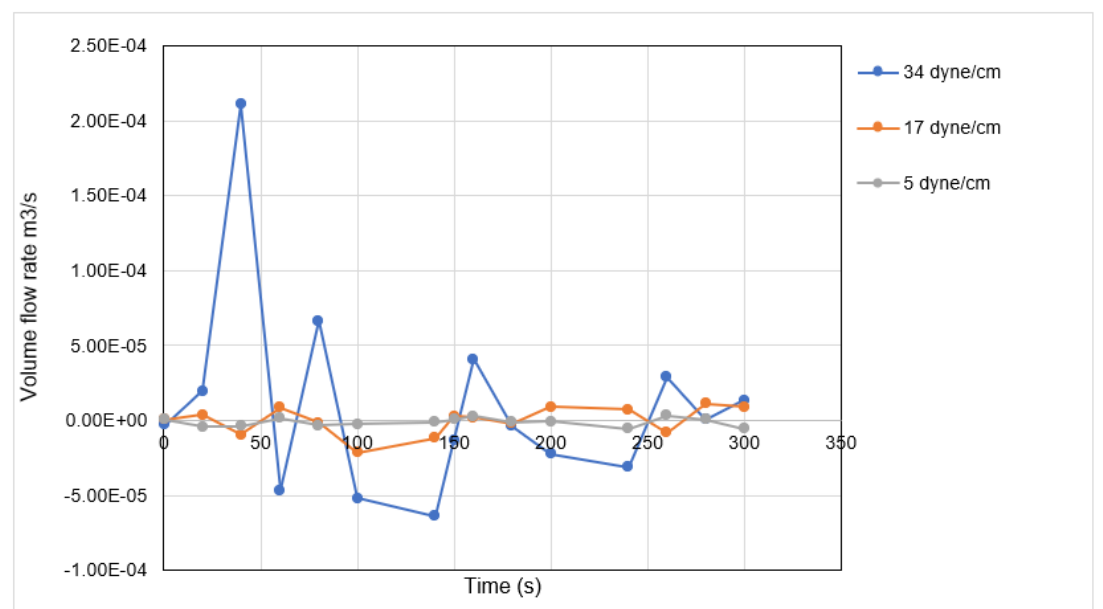
Figure 12. Volumetric flow rate of oil produced against time for case 1, case 2, and case 3. The flow for case 1 (0.034 N/m) was characterised by negative volumes.